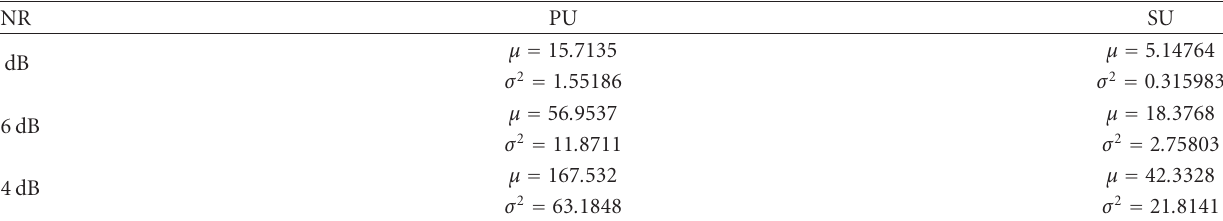
Figure 10: Empirical capacity regions (128/2048 subchannels, P PU = 80% & P PU = 20%), SNR = 8dB, 16 dB, and 24 dB. Table 1: Parameters of the fitted